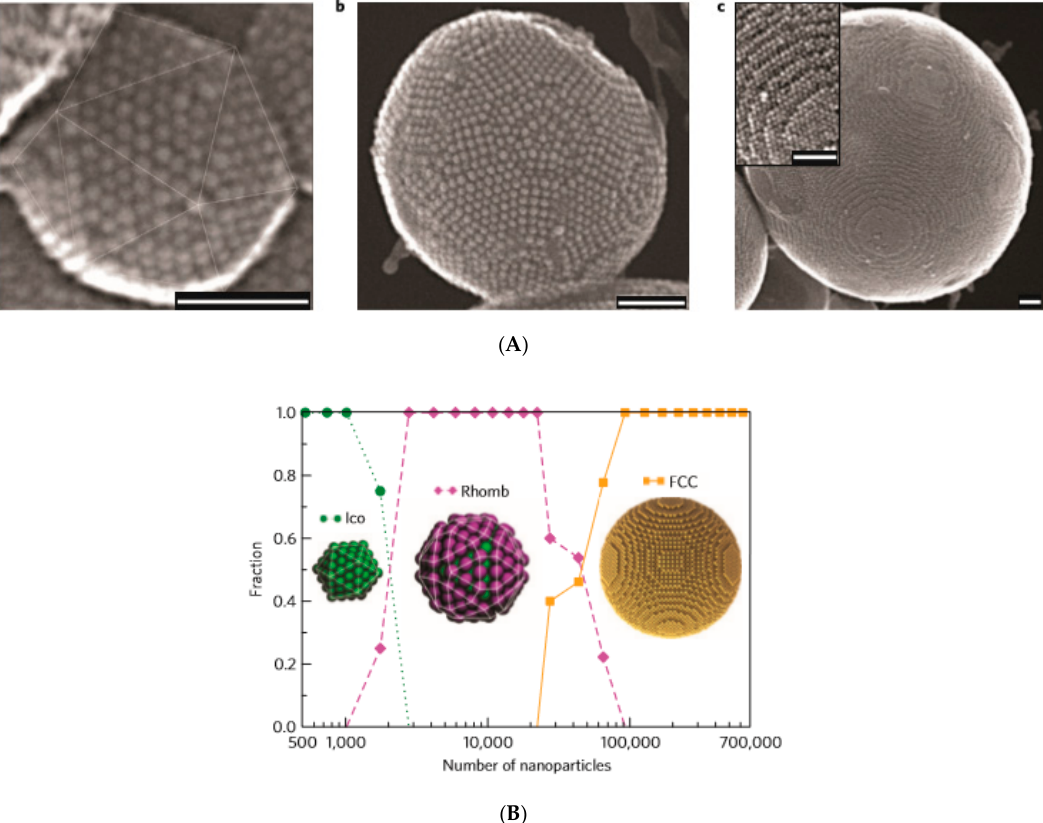
Figure 2. Entropy ‐ driven supraparticle assembly. ( A ) Secondary electron scanning transmission electron microscopy (SE ‐ STEM) images of typical supraparticles containing oleic acid coated cobalt– iron oxide nanoparticles initially dispersed in cyclohexane (core diameter 6 nm; hydrodynamic diameter 9 nm). ( a ) Supraparticle with a diameter of 105 nm with Mackay icosahedral symmetry, as indicated by the thin lines. ( b ) 216 nm supraparticle with anti ‐ Mackay